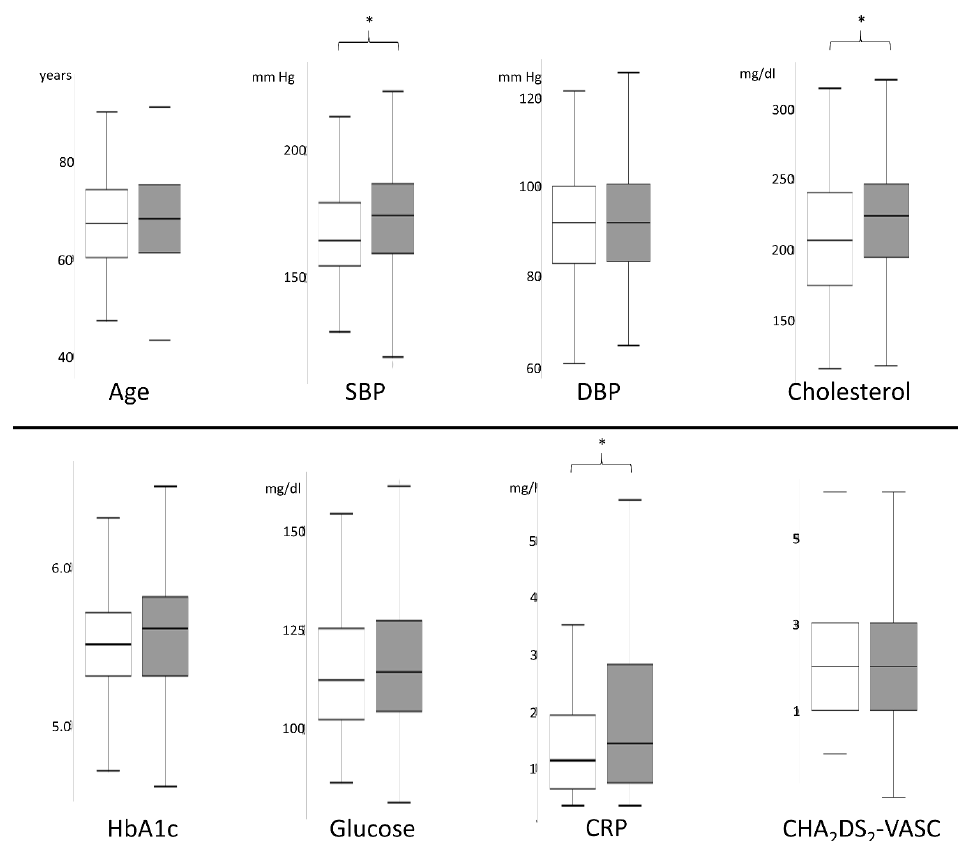
Figure 2. Comparison of the parameters of the vascular risk profile between female (grey) and male (white) TGA patients using boxplots showing higher systolic blood pressure, higher cholesterol levels, and higher C-reactive protein on admission in female TGA patients compared to male (* p < 0.05).